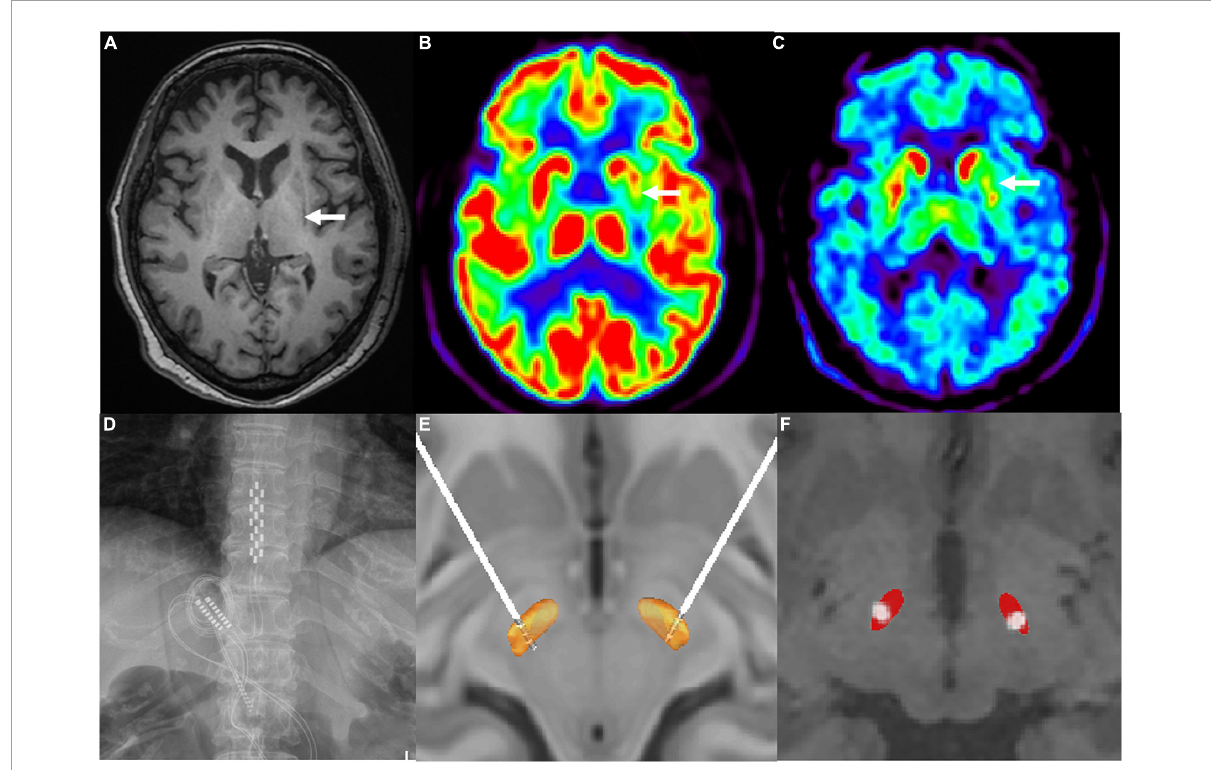
FIGURE1 (A) Left hypointense lateral putaminal rim on T1-signal cranial magnetic resonance imaging (as indicated by the white arrow). (B) 18 F-fluorodeoxyglucose positron emission tomography scan revealed reduced in glucose metabolisms in the left putamen (as indicated by the white arrow). (C) 18 F-fluoropropyl-(+)-dihydrotetrabenazine positron emission tomography scan revealed hypometabolism in the left putamen (as indicated by the white arrow). (D) paddle-shaped electrode of spinal cord stimulation implanted into the epidural space at T10–T12 spinal cord segments. (E) 3D illustration for the localization of deep brain stimulation electrode contacts (model 3389, Medtronic) by the lead DBS software. Electrodes were implanted as follows: contacts 0, 1, and 2 were located inside the STN and contact 3 was located above the STN. (F) 2D illustration for the localization of active contacts by the lead DBS